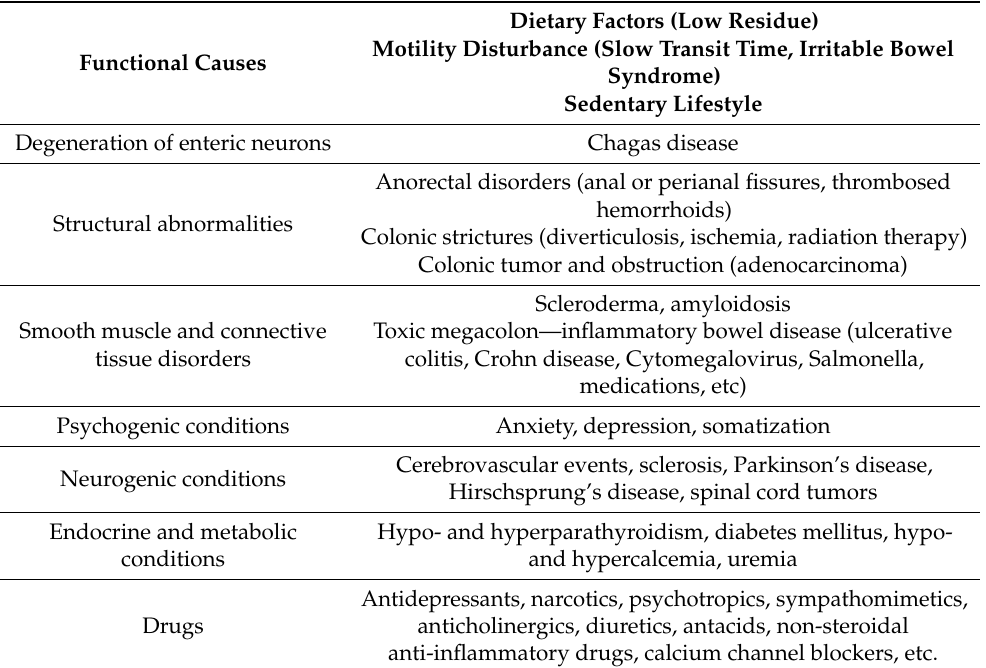
Table 1. Various pathological and non-pathological conditions that associate constipation as a clinically important